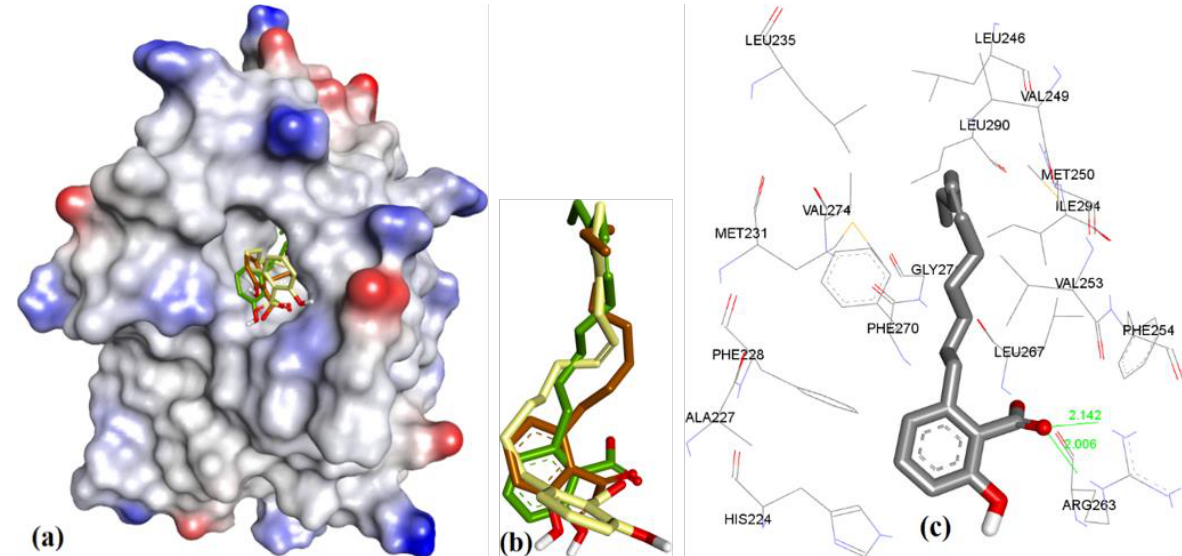
Figure 9. ( a ) The ionized solvent-exposed surface mapping of hMcl-1 along with the docked poses of 3b from MOE (in brown), AutoDock (in green), and VlifeDock (in yellow) show their fitting to the cavity. ( b ) Similar-pose ensemble clustering of all three poses was attained from the three different docking methods. ( c ) Binding mode of 3b .